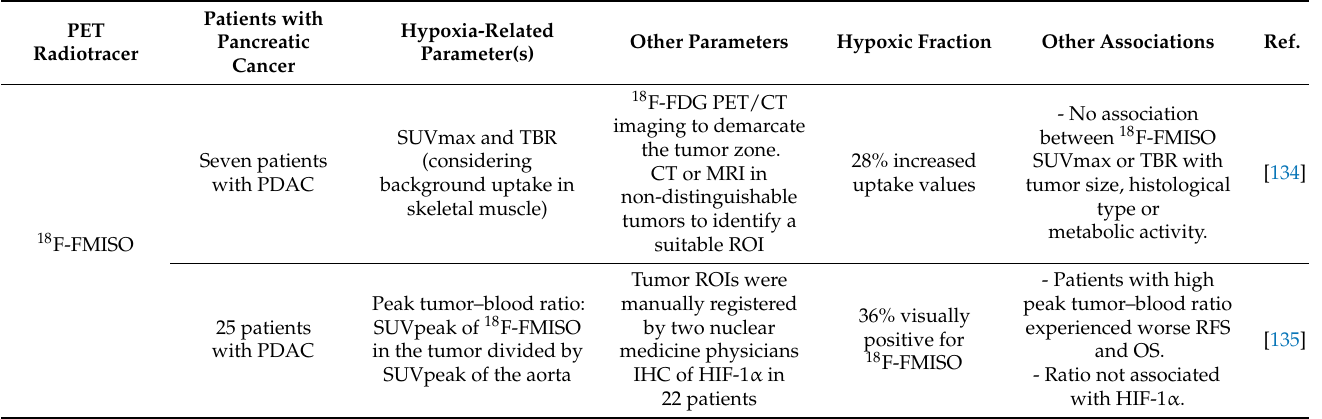
Table 3. Application of PET radiotracers for the detection of hypoxia in patients with